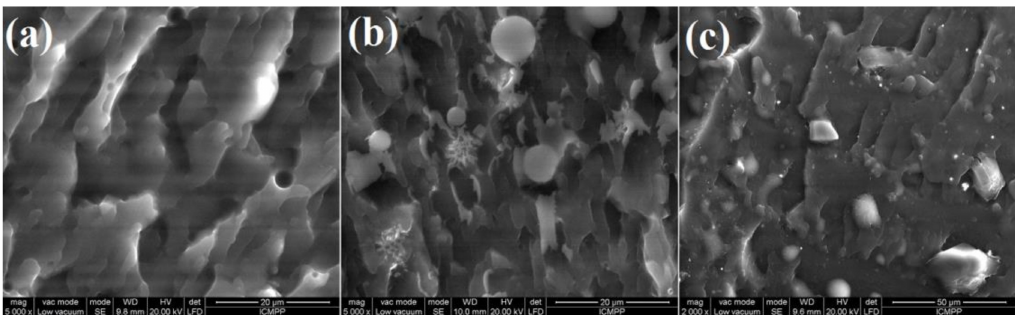
Figure 7. SEM images of polymeric films (in fracture) for L1 without particles ( a ), L2 with ZnO ( b ) and L3 with ZnO-SnO 2 ( c